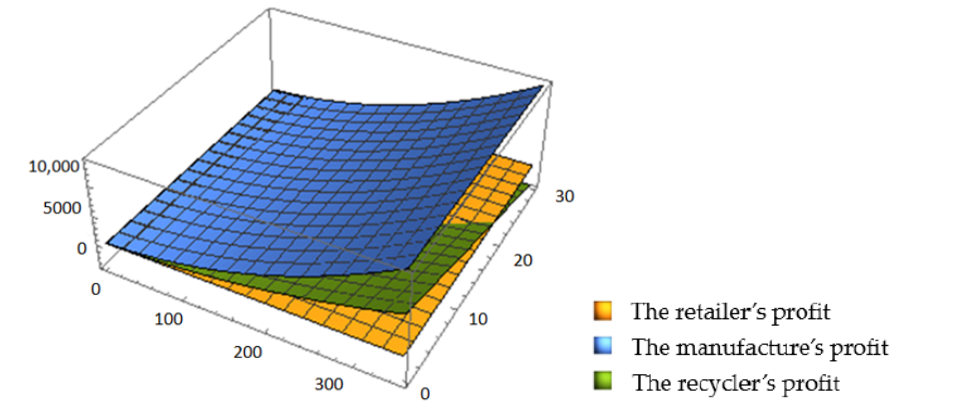
ff ects of ε and q 0 on each member’s profit in CLSC. Figure 4. Effects of  and q 0 on each member’s profit in CLSC. Figure 4. E